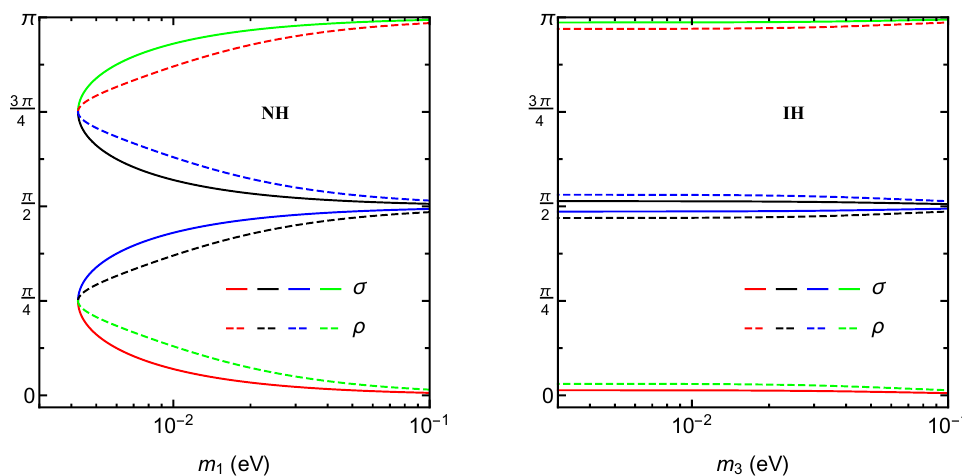
in the NH case or m in the IH 1 3